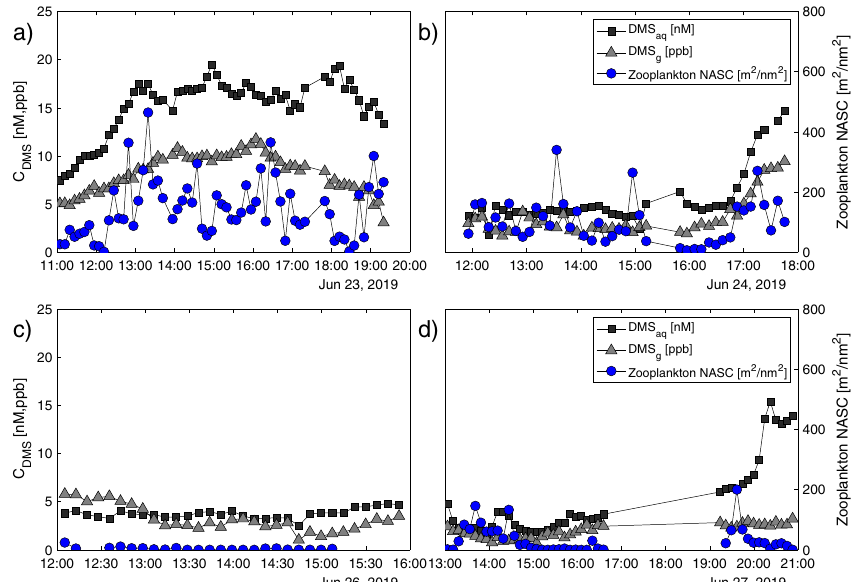
Fig. 2 Dimethyl sul fi de (DMS) concentrations in air and seawater and zooplankton biomass off the coast of Cape Cod, MA, USA, measured concurrently on four separate survey days. a A time series of all three measurements (DMS in air, DMS in seawater, and prey biomass) on 23 June 2019, b 24 June 2019, c 26 June 2019 and d 27 June 2019. There were large variations in all three parameters both within and among the days, although trends of high and low values for each parameter existed. Zooplankton biomass (as measured acoustically; Nautical Area Scattering Coef fi cient (NASC) (blue circles)) was more variable than either phase of DMS (DMS aq in seawater (black squares); DMS g in the air (grey triangles)) which may be the result of in situ natural variabilities. Only 4 days are shown as the duration of sampling was short on the fi fth day ( n = 14, ~1.5 h).